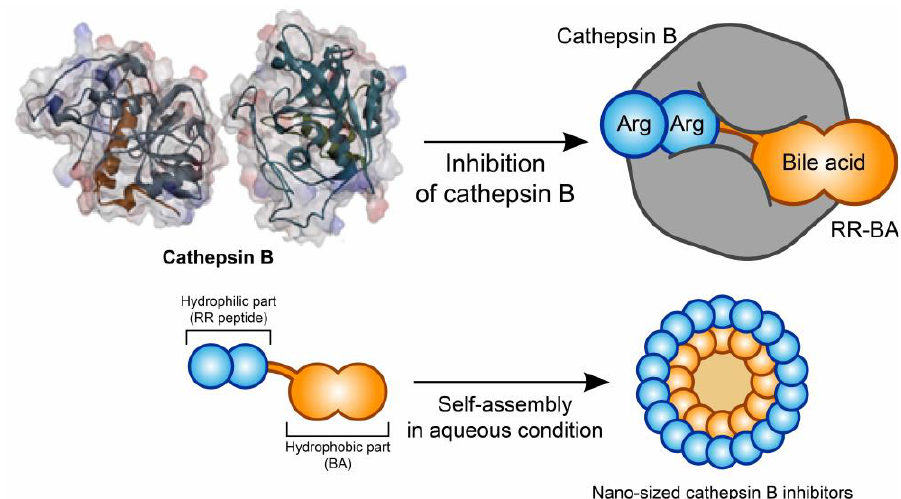
Figure 1. Schematic image of self-assembled amphiphilic bile-acid-based cathepsin B inhibitory nanoparticles. RR–BA molecules can be self-assembled in aqueous conditions from RR peptides and bile acid due to their amphiphilicity. RR–BA molecules could act as cathepsin B inhibitors because they have a cathepsin B binding site.